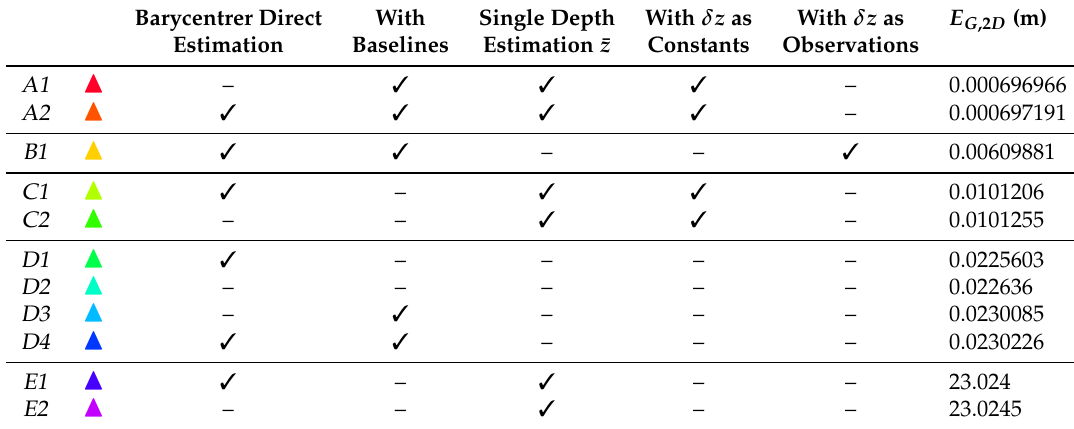
Table 3. Distance to true barycenter for different inversion protocols for a drifting trajectory inscribed in a 1000m radius